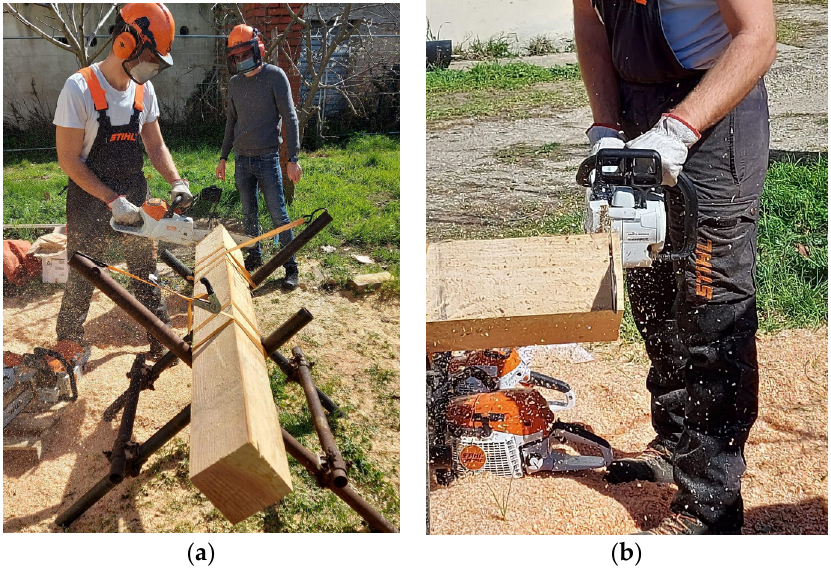
Figure 1. Chainsaw operator during cutting and video recording ( a ) and cutting of a ~2 cm-wide cross-section ( b ).